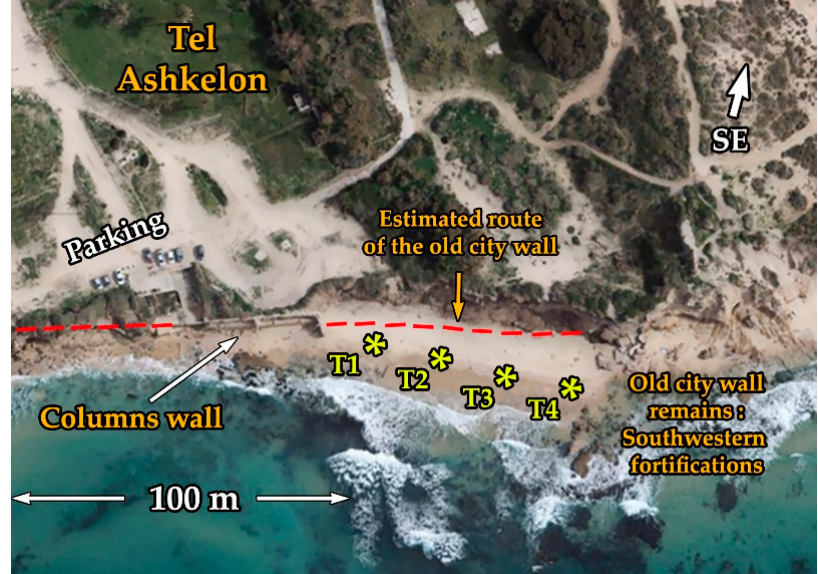
Figure 5. Native sand sample (T1–T4) locations in Tel Ashkelon beach near the Columns wall. View to southwest, about 3 km from Ashkelon Port. (Photo: Orthophoto Israel, 16 July 2014).